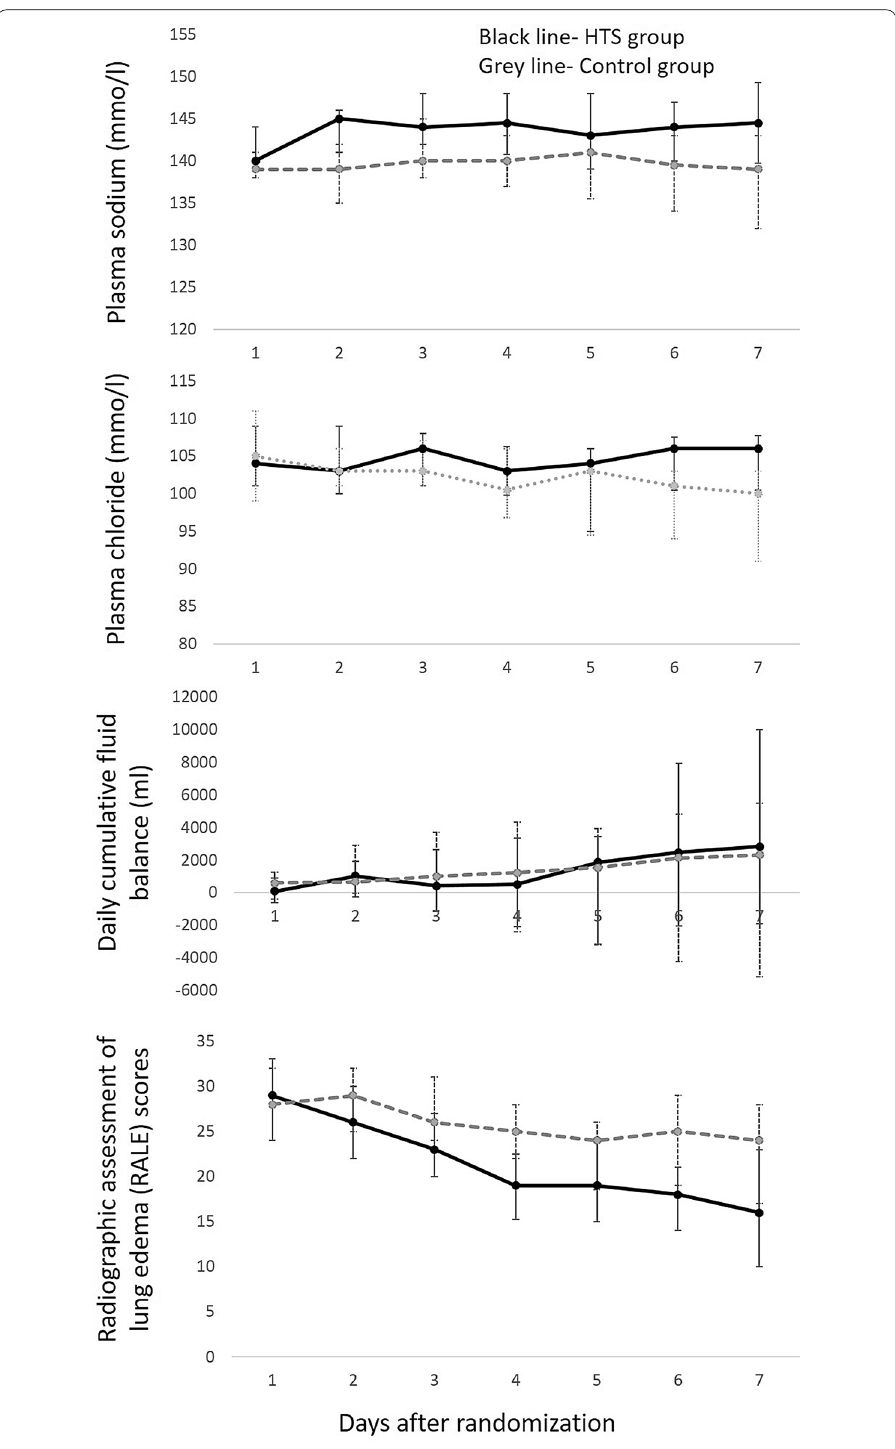
Fig. 2 Highest daily plasma sodium, chloride levels, cumulative fluid balance and radiographic assessment of lung edema (RALE) score in the study participants during the first 7 days of the study. There was a difference in the daily sodium and chloride levels ( p 0.04 and 0.03, respectively), but no difference between the = cumulative fluid balances ( p 0.48) between the groups. There was a difference in the daily RALE score = ( p 0.03) between the groups during the study period. Data presented as median and IQR over =